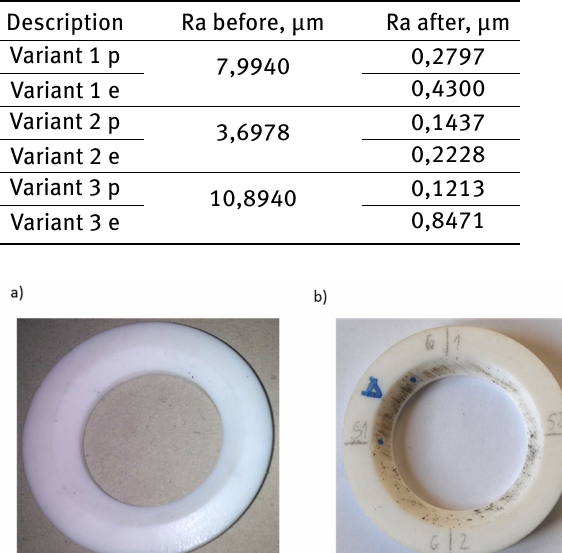
The measured roughness parameters of tested seals